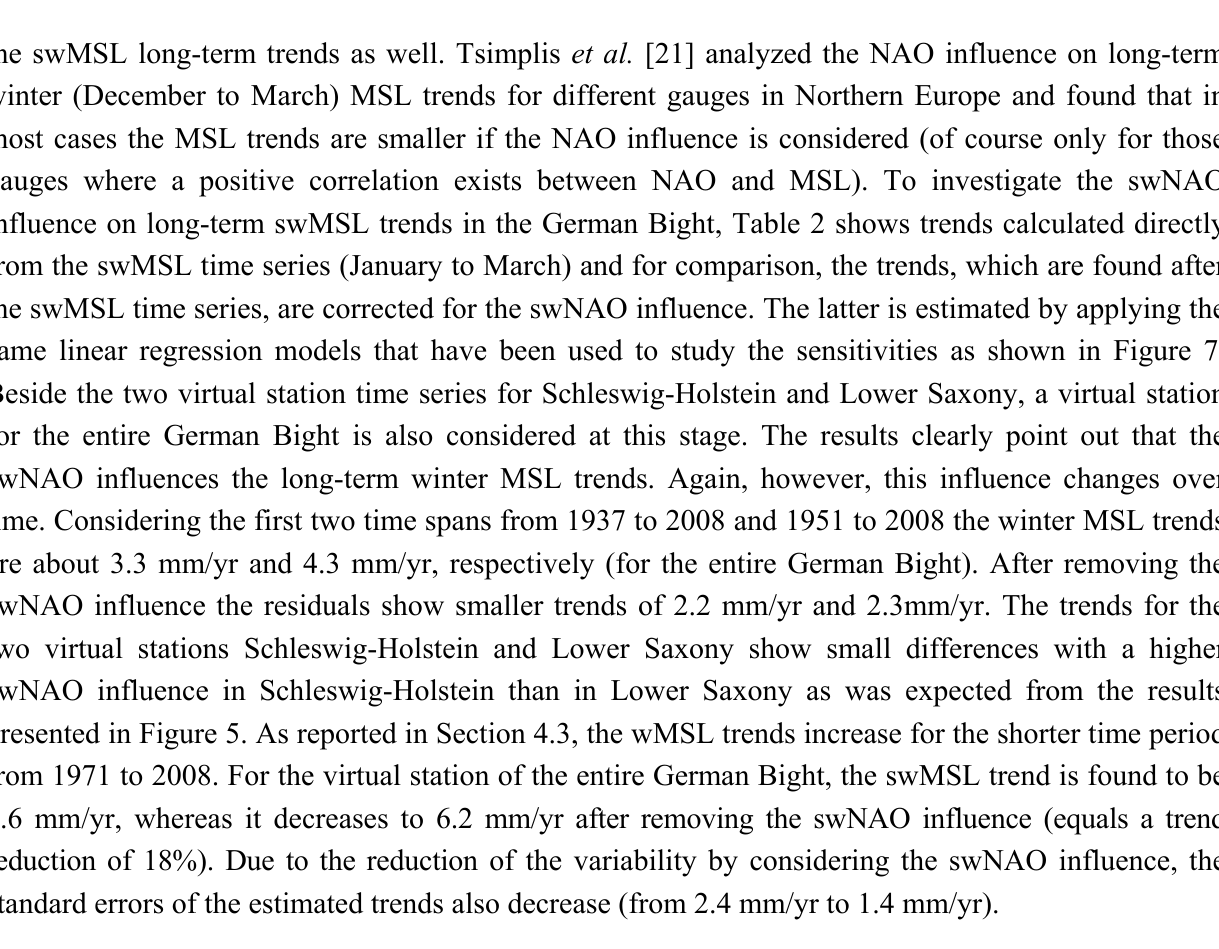
Table 2 . Linear trends for the swMSL of three synthetic tide gauges before and after swNAO correction (trends which change significantly after removing the NAO influence are marked